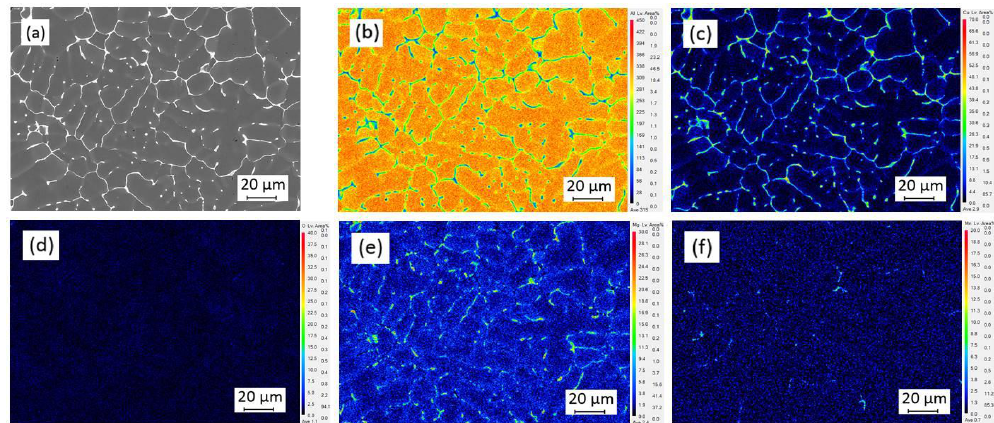
Figure 6. Elements map-scanning of 1 / 2 radius region of as-cast alloy cast by LFEC with 10 Hz / 150 A ( a ) SEM micrograph of as-cast al loy; ( b ) Al; ( c ) Cu; ( d ) O; ( e ) Mg; ( f ) Mn.